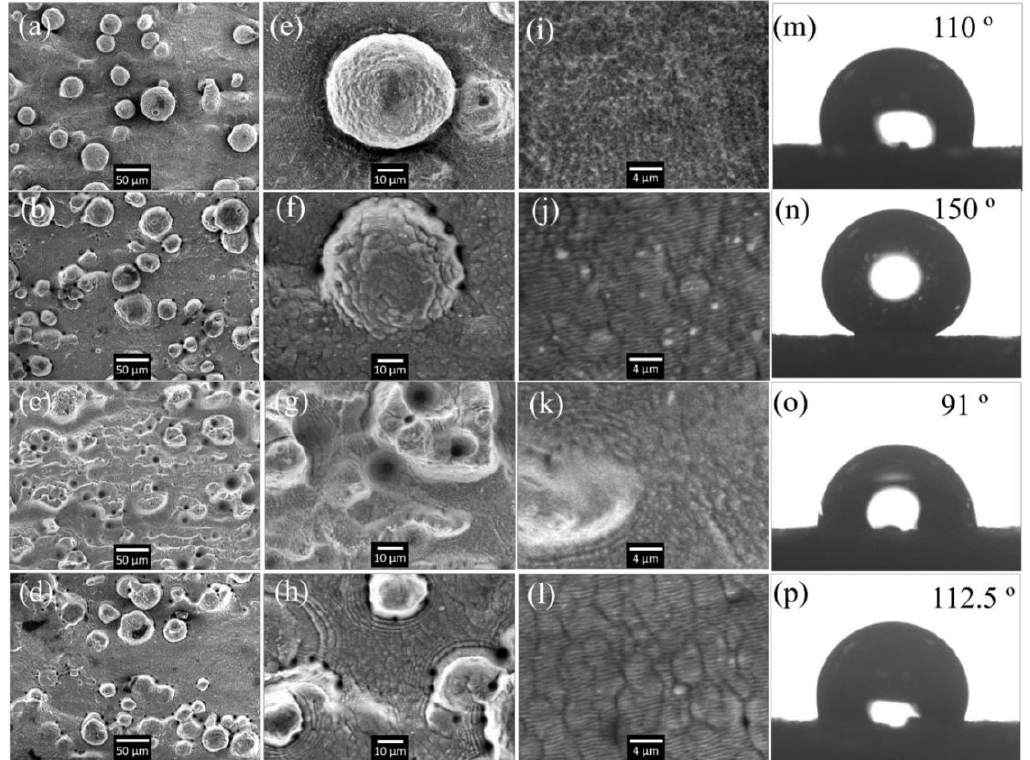
Figure 4. SEM images of the AM parts surface processed by fs laser in ethanol with scanning speed of 80 mm/s ( a , e , i ; first row); in ethanol with scanning speed of 40 mm/s ( b , f , j ; second row); in ethanol with scanning speed of 20 mm/s ( c , g , k ; third row); in air with scanning speed of 40 mm/s ( d , h , l ; last row); water droplet and water contact angle (WCA) on the corresponding structures ( m – p